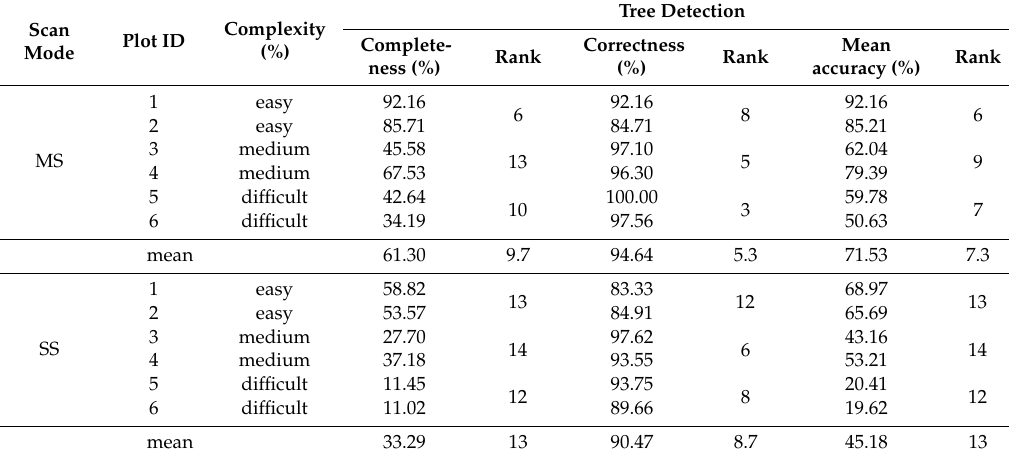
Table 7. Comparison of tree detection with the benchmark